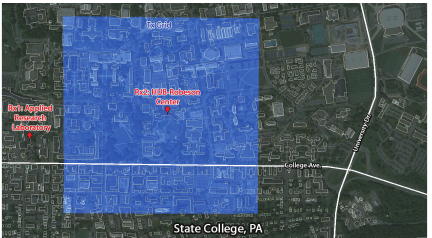
Figure 1: 2D representation of the Wireless InSite model overlaid on satellite image of State College, PA. The transmitter grid covers the blue overlay. Rx1 corresponds to the receiver location of Scenario A, and Rx2 corresponds to the receiver location of Scenario B, © 2013 Google Earth.